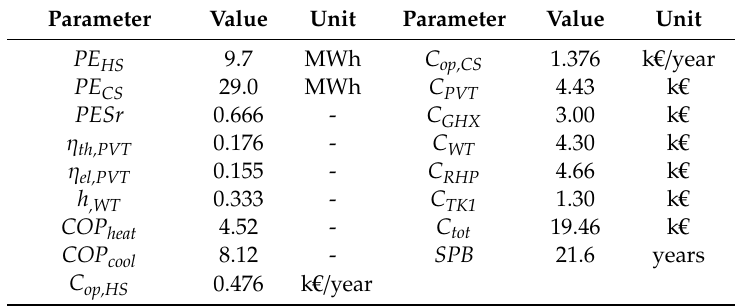
Table 5. Main energy and economic parameters of the system, yearly results.